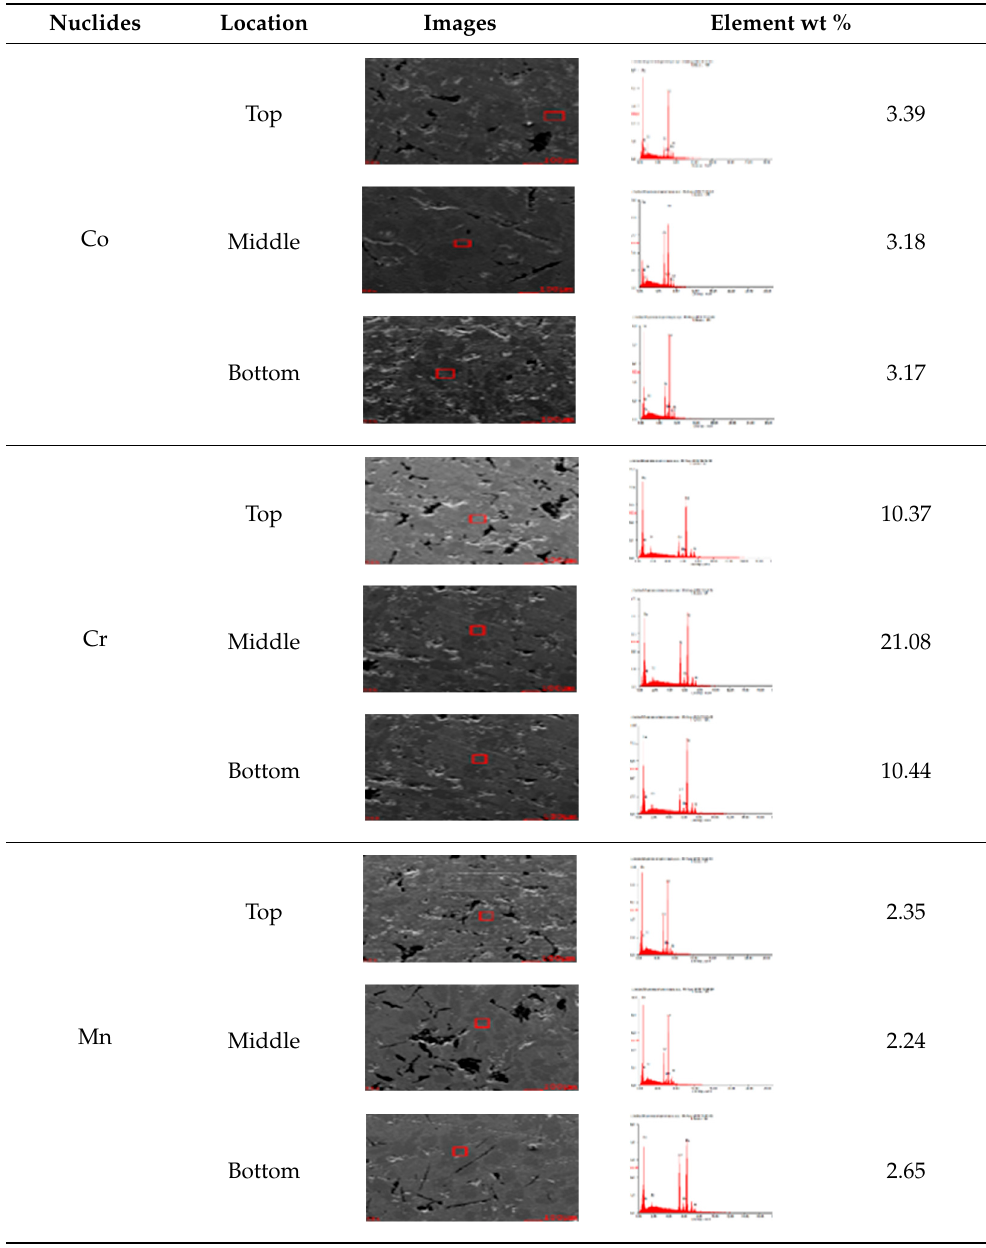
Table 10. Analysis results of distribution.